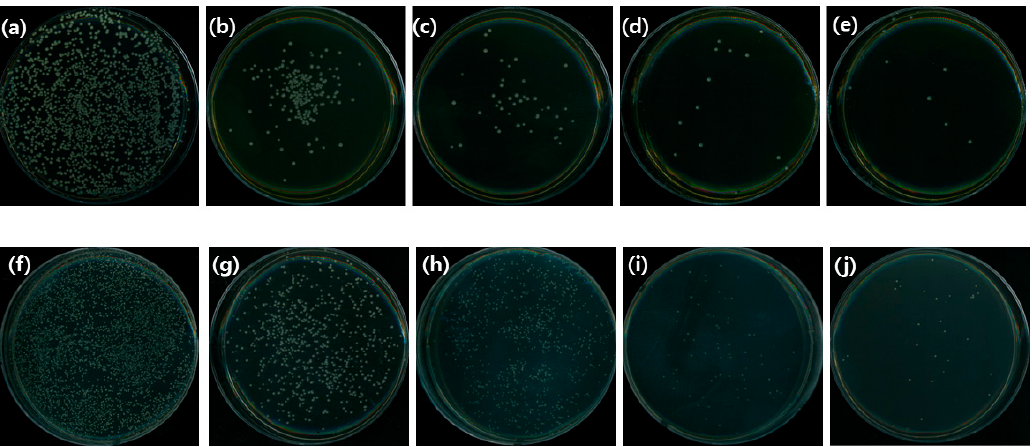
Figure 5. CFU results for S. mutans group ( a ) 0 µ g/mL ( b ) 50 µ g/mL ( c ) 100 µ g/mL ( d ) 150 µ g/mL ( e ) 200 µ g/mL); C. albicans group ( f ) 0 µ g/mL ( g ) 50 µ g/mL ( h ) 100 µ g/mL ( i ) 150 µ g/mL ( j ) 200 µ g/mL).